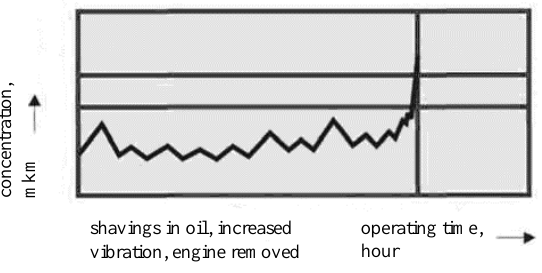
Fig. 2. Change of metal content in oil during fatigue damage of rubbing